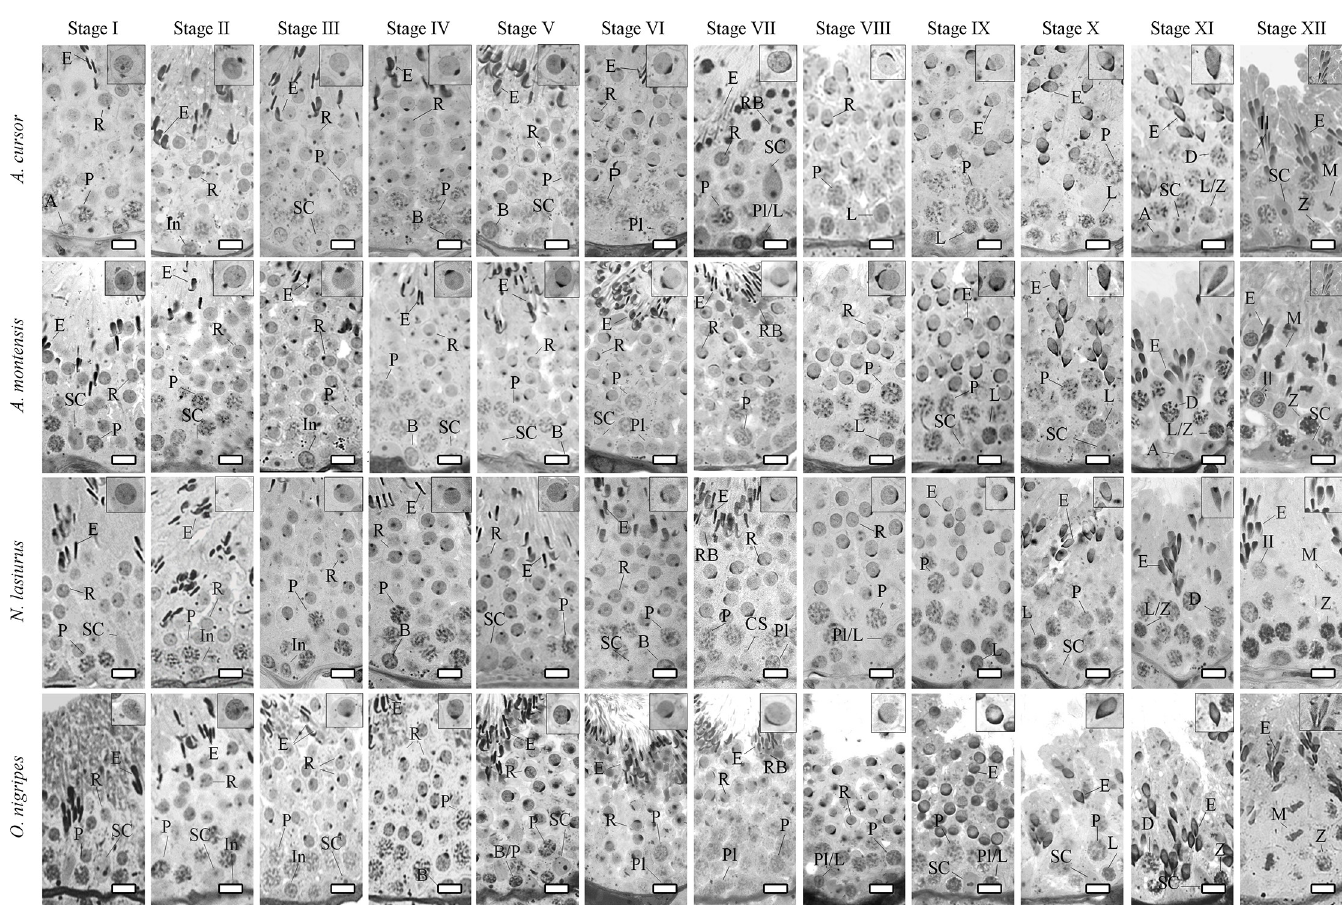
Fig 1. Different stages of the seminiferous epithelium cycle characterized according to the acrosome system in the four wild rodent species investigated. Twelve stages were characterized. The inserts in the upper right corner show a representative spermatid step present in each stage. Abbreviations: type A spermatogonia (A); intermediate spermatogonia (In); type B spermatogonia (B); pre-leptotene spermatocytes (Pl); pre-leptotene in the transition to leptotene spermatocytes (Pl/L); leptotene spermatocytes (L); leptotene in the transition to zygotene spermatocytes (L/Z); zygotene spermatocytes (Z); pachytene spermatocytes (P); diplotene spermatocytes (D); secondary spermatocytes (II); meiotic divisions (M); round spermatids (R); elongating/elongated spermatids (E); Sertoli cells (SC); and residual bodies (RB). Bar = 10 μ